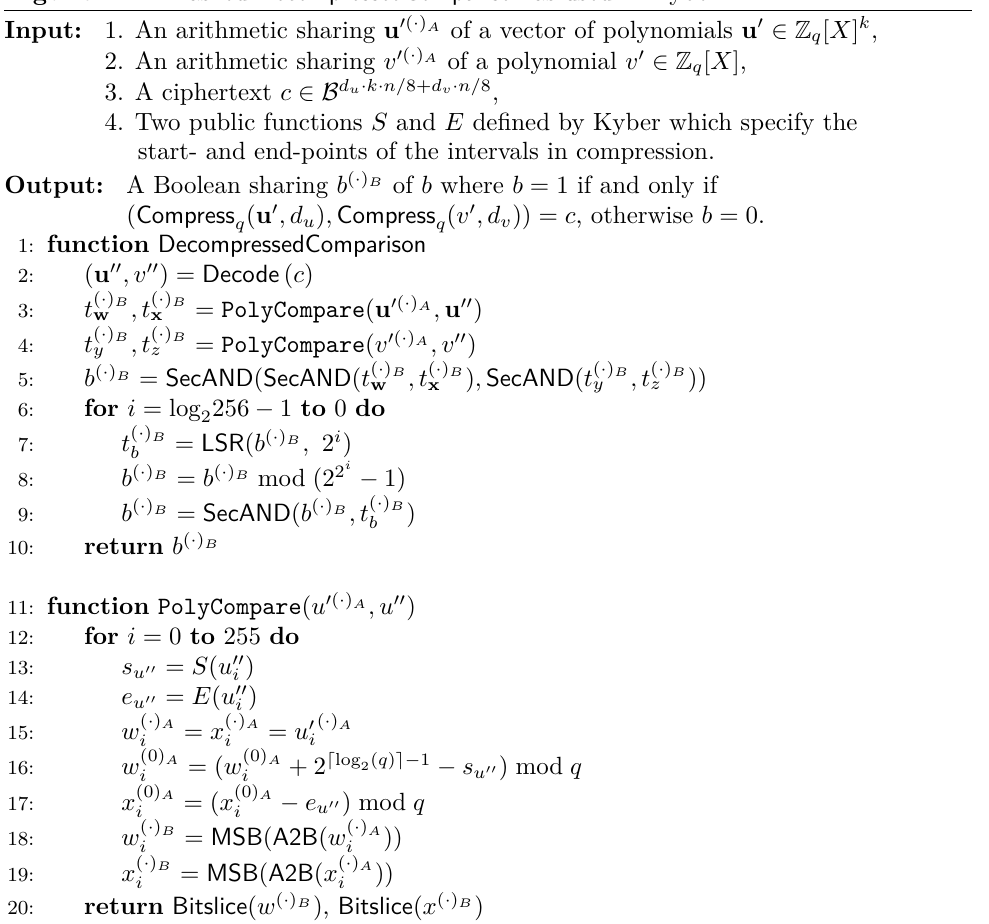
Algorithm 2 Masked DecompressedComparison as used in